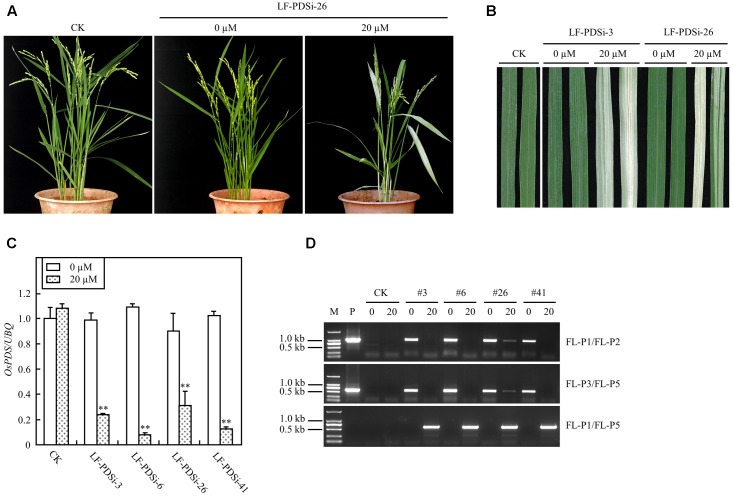
Induced OsPDS silencing in mature LF-PDSi transgenic rice plants. (A) Phenotype of mature plants developed from seeds soaked in liquid solution with 0 or 20 μM estradiol. CK, non-transgenic wild type control; LF-PDSi-26, pXCLF-PDSi-transformed rice line #26. (B) Phenotype of leaves from mature plants developed from seeds soaked in liquid solution with 0 or 20 μM estradiol. CK, non-transgenic wild type control; LF-PDSi-3, LF-PDSi-26, pXCLF-PDSi-transformed rice line #3 and #26. (C) qRT-PCR analysis of endogenous OsPDS mRNA level in mature plants developed from seeds soaked in liquid solution 0 or 20 μM estradiol. CK, non-transgenic wild type control; LF-PDSi-3, LF-PDSi-6, LF-PDSi-26, LF-PDSi-41, pXCLF-PDSi-transformed rice line #3, #6, #26, and #41. Statistical significances (∗∗P < 0.01) between plants developed from seeds soaked in 0 or in 20 μM estradiol were analyzed by Student’s t-test. (D) PCR analysis of chemical-induced site-specific DNA recombination in LF-PDSi transgenic rice plants. P, plasmid control pXCLF-PDSi; CK, non-transgenic wild type control; #3, #6, #26, and #41, pXCLF-PDSi-transformed rice line #3, #6, #26, and #41; 0, plants developed from seeds soaked and germinated in liquid solution with 0 μM estradiol; 20, plants developed from seeds soaked and germinated in liquid solution with 20 μM estradiol.